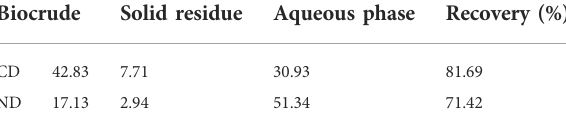
Table 4. The chemical compounds detected can be divided into